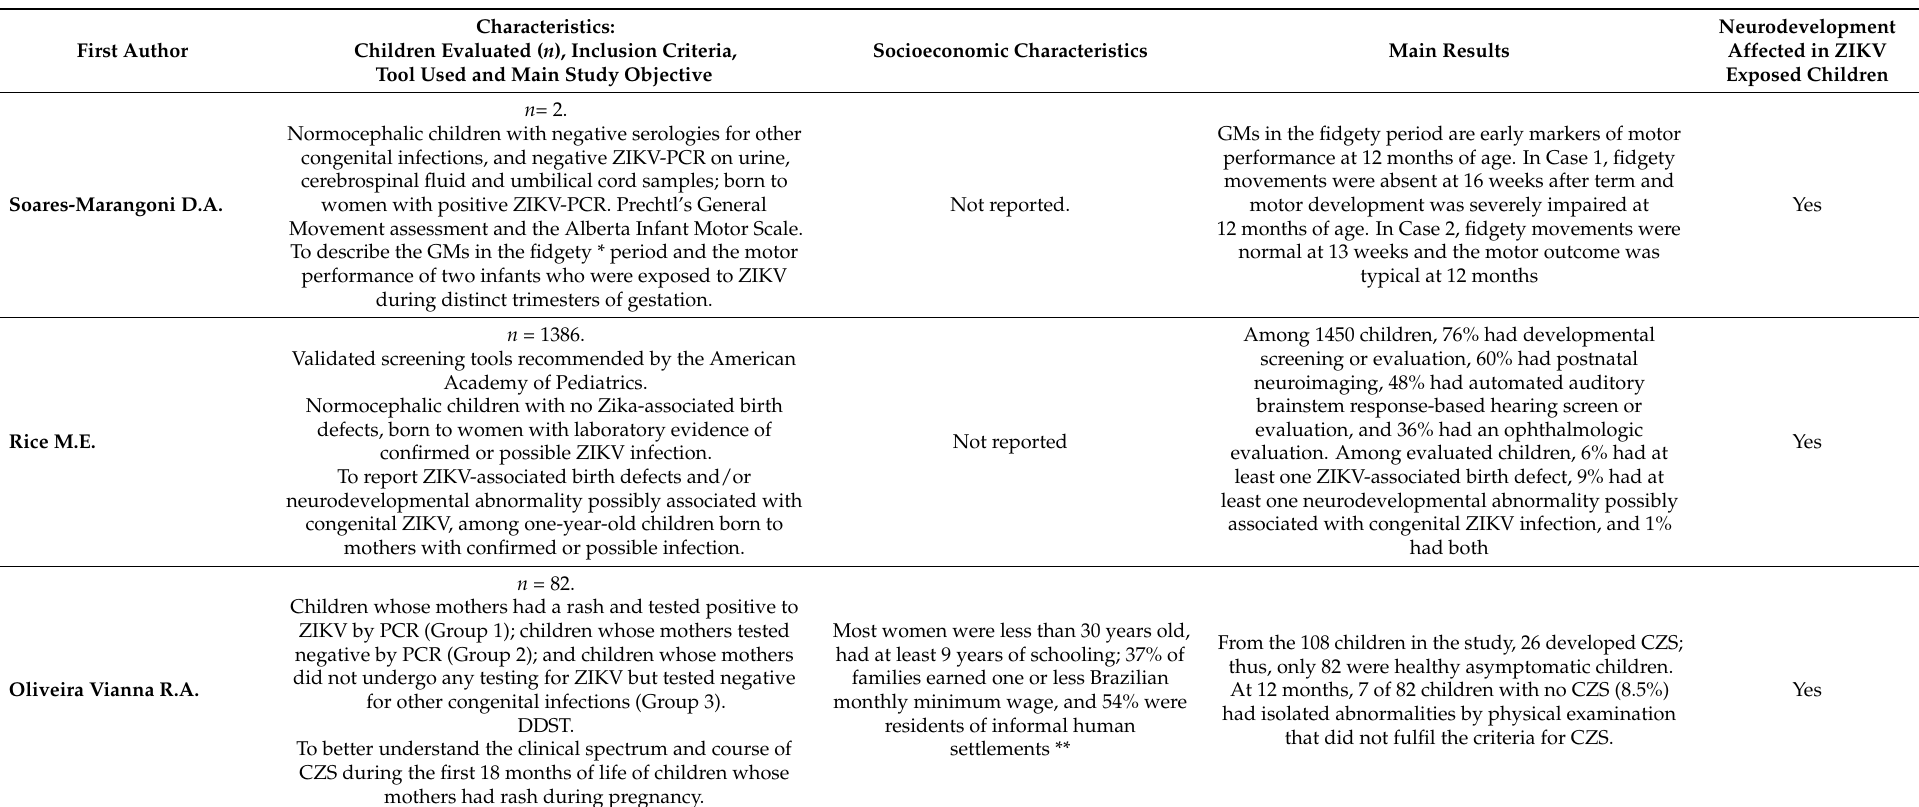
Table 2. Main results from the articles evaluating infant or child neurodevelopment with a tool other than